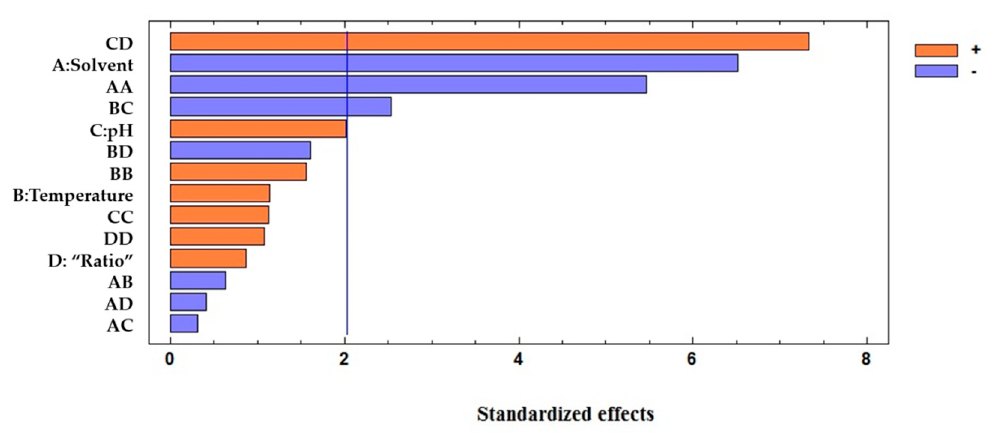
Figure 2. The obtained standardized Pareto chart representing the optimization of the total anthocyanins extraction. Table 1. Coefficients of the second-order polynomial equation obtained using the Box-Behnken design.